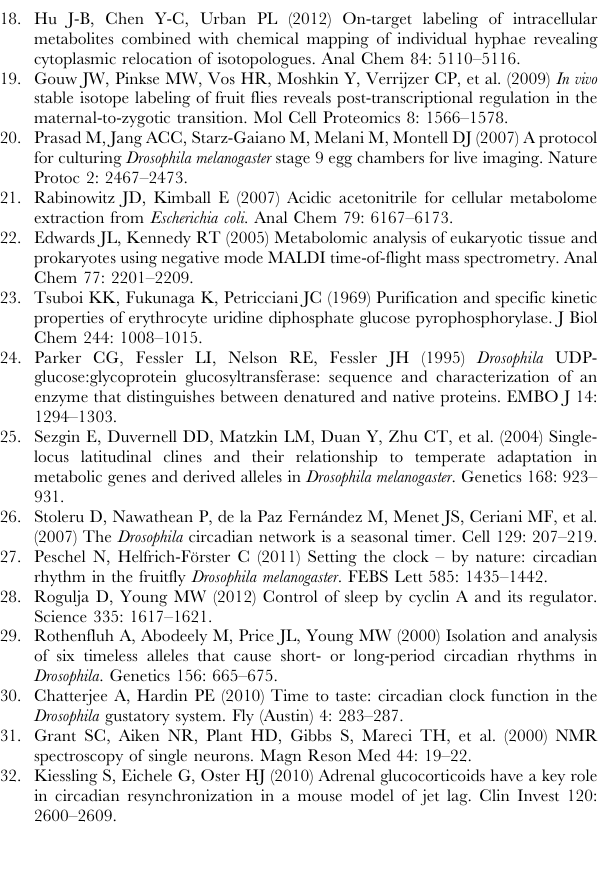
Table S2 Results ( p -values) of the two-sample Kolmogorov- Smirnov test performed on the data obtained in this study. ML – flies incubated during day (starting from the morning) at light; MD – flies incubated during day (starting from the morning) at dark; EL – flies incubated during night (starting from the evening) at light; ED – flies incubated during night (starting from the evening) at dark. Null hypothesis: the two data sets are from the same continuous distribution. Red color indicates the p -values where the null hypothesis is rejected (at the 5% significance level). Table S3 Numbers of eggs with the labeling level higher or equal to 0.5 in each of the four groups. ML – flies incubated during day (starting from the morning) at light; MD – flies incubated during day (starting from the morning) at dark; EL –